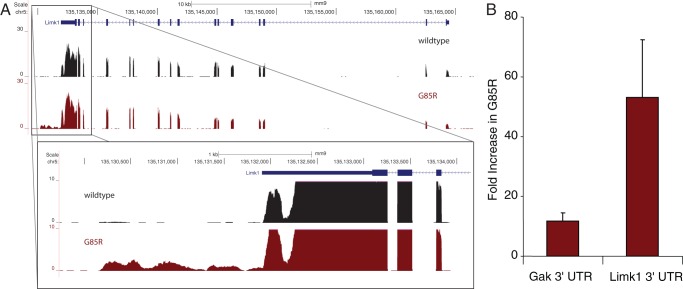
Differential expression of novel TARs in G85R motor neurons.A. RNA-Seq signal plots in reads per million mapped reads at the Limk1 gene from wild-type (black) and G85R (red) motor neurons. The canonical Limk1 gene map is shown at the top. The enlarged region shows a clear 3′-UTR extension in G85R motor neuron RNA. Similar data were observed for Gak (not shown). B. Validation of novel 3′-UTRs of Gak and Limk1 by qRT-PCR. Values are relative expression for each 3′-UTR in G85R versus wild-type motor neuron RNA.